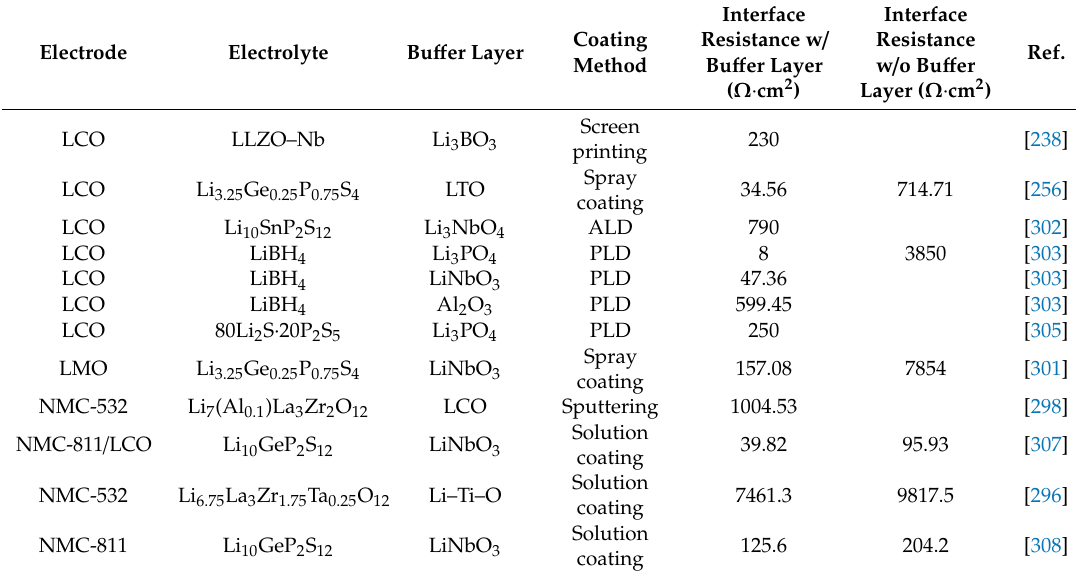
Table 4. Comparison of the interface resistance with (w / ) and without (w / o) bu ff er layer on solid-state electrolyte /